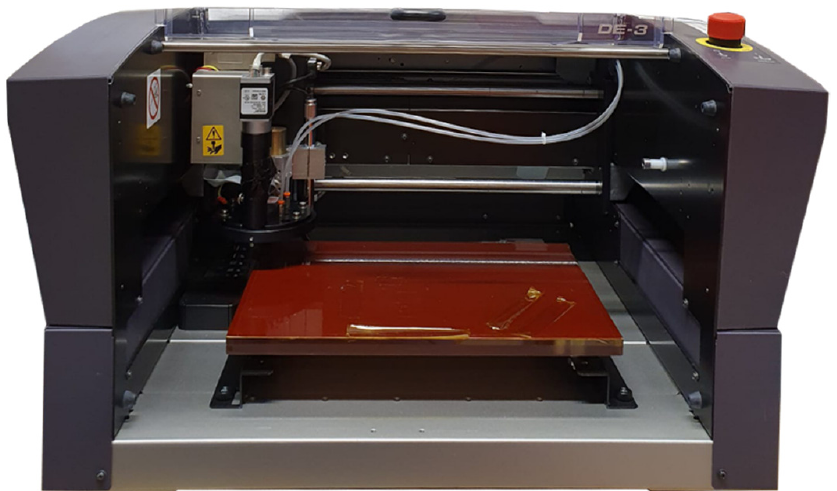
Figure 1. Image of μ Plasma system. Figure 1. Image of µ Plasma